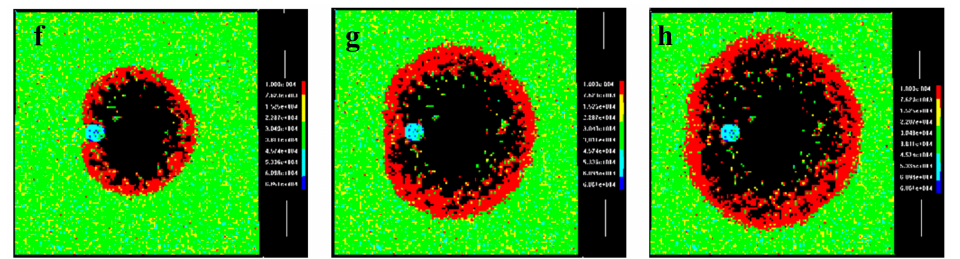
Figure 15. HF geometries during the fracturing process in Case F. ( a , b ) respectively show the cross section and longitudinal before fracturing; ( c – e ) correspond to those in the cross section; ( f – h ) correspond to those in the longitudinal